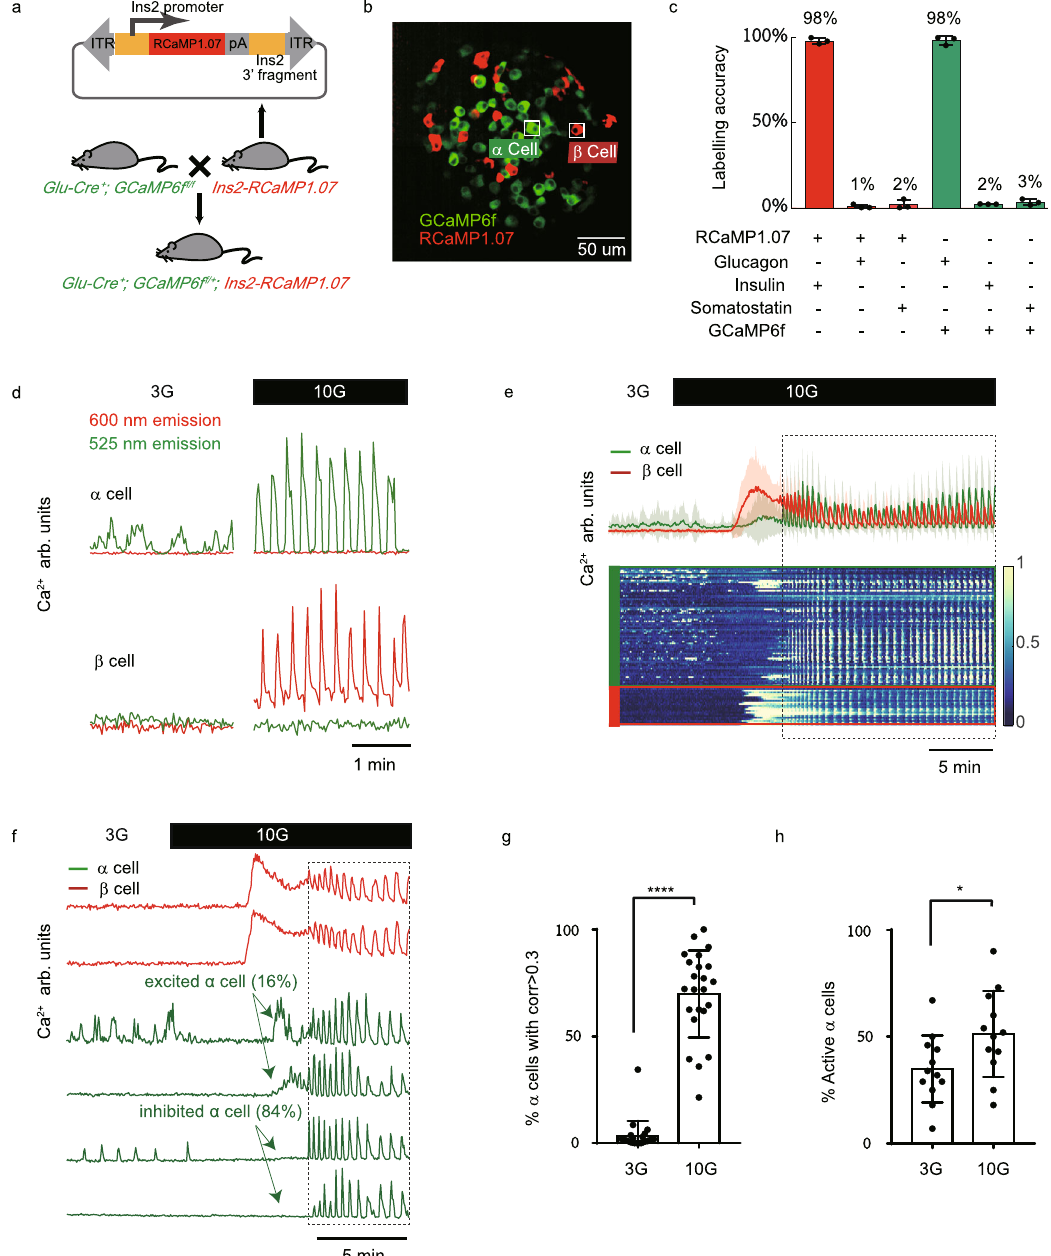
Fig. 2 Using Glu-Cre + ; GCaMP6f f/ + ; Ins2 - RCaMP1.07 transgenic mice to identify islet α and β cells. a Gene targeting vector designed with Ins2 5 ’ - promoter, RCaMP1.07 , and Ins2 3 ’ -fragment for constructing the Ins2-RCaMP1.07 mice. b Maximal projection of Ca 2 + activity from the Glu-Cre + ; GCaMP6f f/ + ; Ins2 - RCaMP1.07 mice islet. α cells expressed GCaMP6f (Green) and β cells sparsely expressed RCaMP1.07 (Red) (see Methods). c Immuno fl uorescence co- localization analysis of Ins2-RCaMP1.07 and Glu-Cre + ; GCaMP6f f/f islet cells. n = 598, 461 and 505 RCaMP1.07 + cells for insulin, glucagon and somatostatin (3 mice). n = 939, 553 and 995 GCaMP6f cells for glucagon, insulin and somatostatin (3 mice). Bars represent mean ± s.d. d 525 nm and 600nm emission (single bandpass fi lter with width 50nm) signals from single α and β cells under 3 G (2.5min) and 10G (2.5 min) stimulation. The cell positions are marked in b . e Mean α (green) and β (red) cells Ca 2 + signal from intact mouse islets exposed to 3 – 10 mM glucose. Shading corresponds to s.d. The lower panel is the heat map of the normalized single-cell Ca 2 + signal. Dashed Box shows the stable oscillatory phase. f Single α (green) and β (red) cell Ca 2 + signals from intact mouse islets exposed to 3 – 10mM glucose. Third and fourth rows: Excited α cell Ca 2 + signals (3G active and inactive). Fifth and sixth rows: Inhibited α cell Ca 2 + signals (3G active and inactive). Dashed Box shows the stable oscillatory phase. g Percentage of synchronized α cells (mean Pearson correlation coef fi cient >0.3) under 3 G and 10G stimulations ( n = 23 islets from 5 mice in 5 independent isolations). Bars represent mean± SEM (standard error of the mean). h Percentage of active α cells (normalized to 25mM KCl stimulated α cell number) under 3 G and 10G stimulations ( n = 12 islets from 4 mice in 4 independent isolations). Bars represent mean